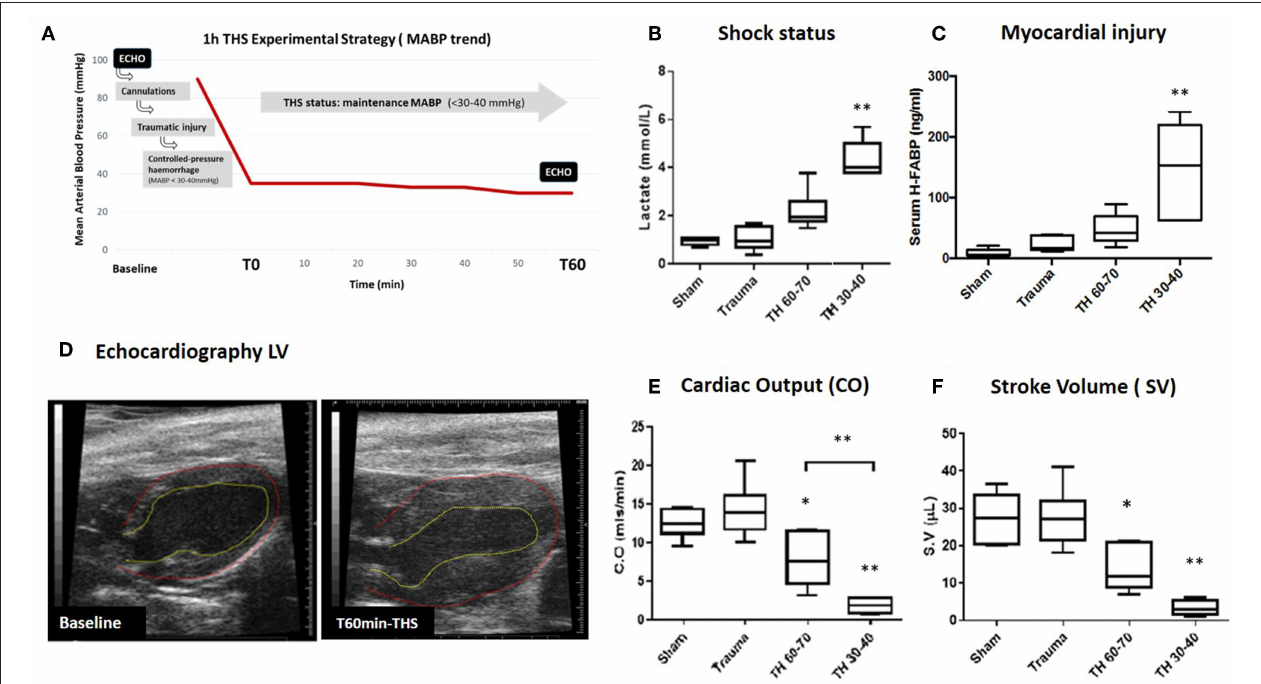
FIGURE 1 | Characterization of the shock status and cardiac dysfunction at 60min post traumatic hemorrhagic shock injury (1h post-THS). (A) Modeling strategy describing the experimental set up with vessel cannulations, traumatic soft and hard tissue injury and pressure-controlled hemorrhage. (B) Median values, interquartile range and range of arterial blood lactate levels at 60min post-THS between the experimental groups (S, sham with only vessel cannulation only; T, Traumatic injury alone; TH 60–70, THS with 60–70 mmHg; MABP and TH 30–40, THS with 30–40 mmHg MABP). ** P < 0.001 between TH 30–40 and S, T, and TH 60–70. (C) Serum H-FABP levels as a myocardial injury biomarker at 60min post-THS between the S, T, and THS 60–70 and 30–40 mmHg groups, showing a significant difference in the THS-30–40 group vs. the others (** P < 0.001). (D) Representative echocardiographic images across the longitudinal heart axis showing the collapsed LV in THS animals at 60min post-injury, in comparison with baseline non-no injured heart; yellow line depicts the endocardium; red line depicts epicardium. (E) Cardiac outcome (CO; ml/min) at 60min post-injury, showing the impact of pre-load effects on the THS 60–70 and the THS 30–40 groups compared to S and T groups (* P < 0.05, ** P < 0.001 between groups; ** P < 0.01 TH 60–70 vs. TH 30–40). (F) Stroke volume (SV; µ L) at 60min post-injury, showing the impact of pre-load effects on the THS 60–70 and the THS 30–40 groups (* P < 0.05, ** P < 0.001 between